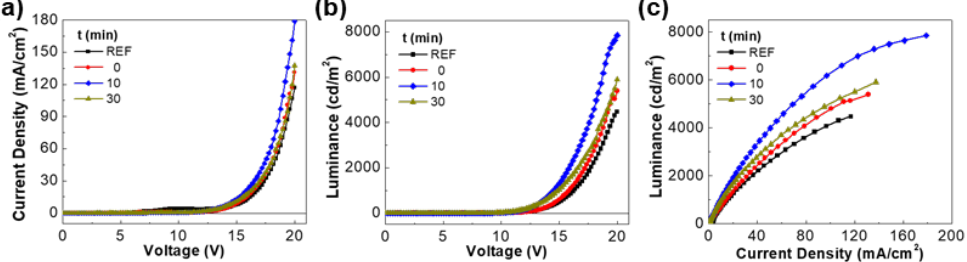
Figure 2. Characteristics of OLEDs with the P3HT layers annealed at 140 ° C for 0, 10, and 30 min: ( a ) current density–voltage (J–V) curves, ( b ) luminance–voltage (L–V) curves, and ( c ) luminance–current density (L–J) curves. Note that the OLED without any P3HT layer is marked as REF (reference device).